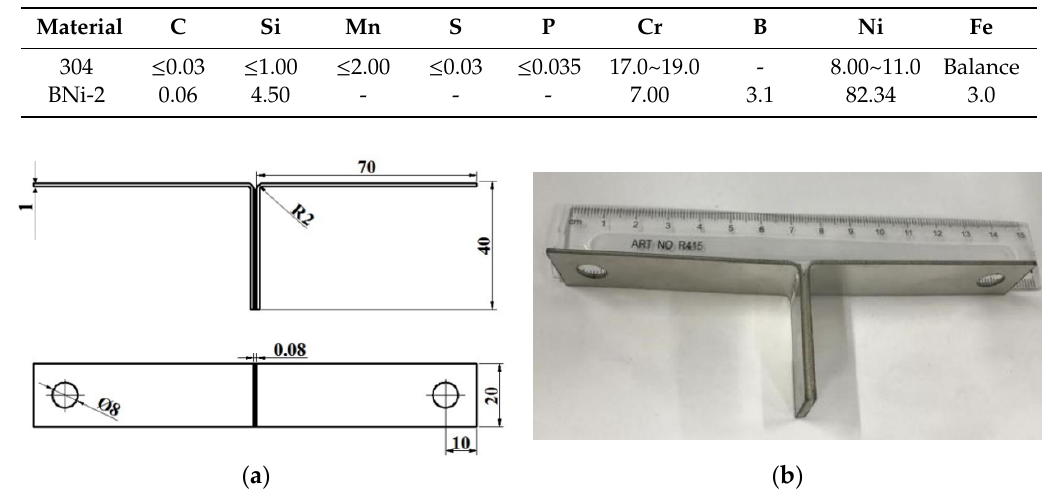
Figure 1. Specimen for a T-type brazed joint: ( a ) schematic geometry and ( b ) photograph.